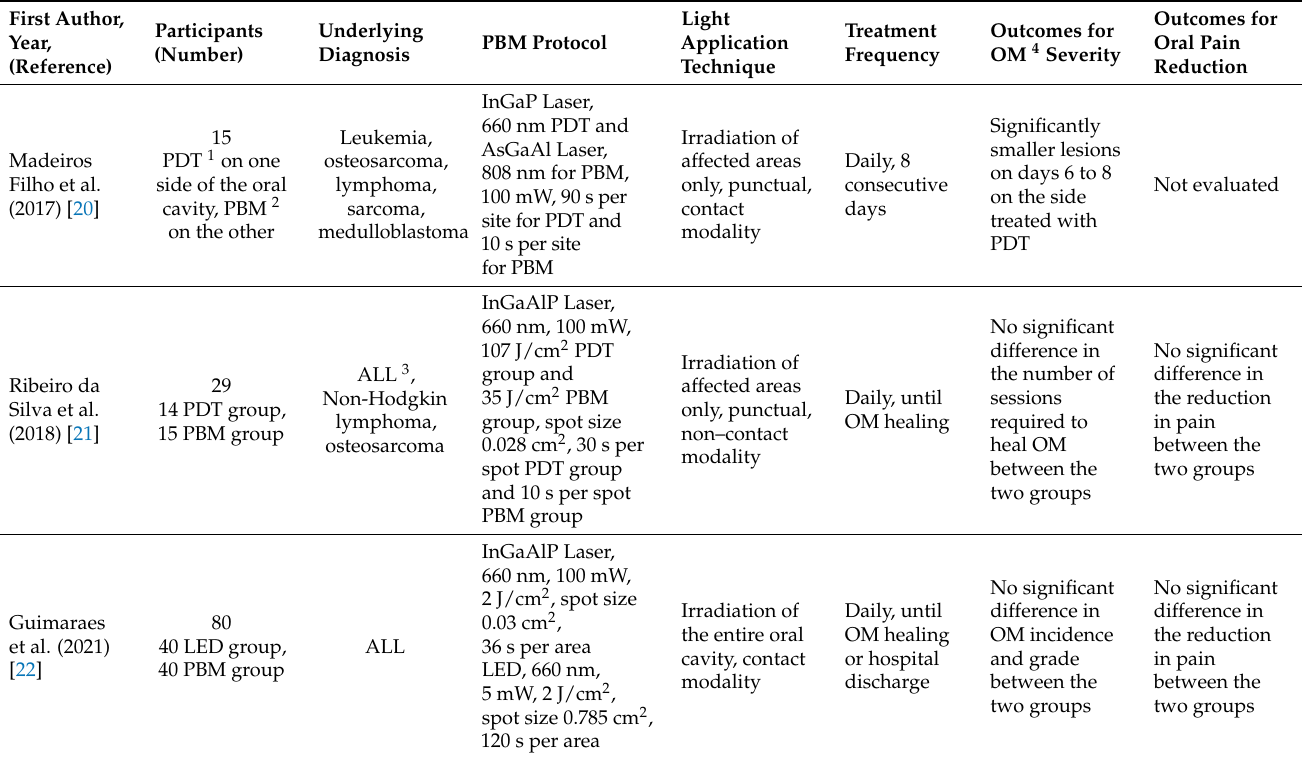
Table 2. Studies addressing other treatment modalities in comparison to PBM for treatment of chemotherapy-induced OM in